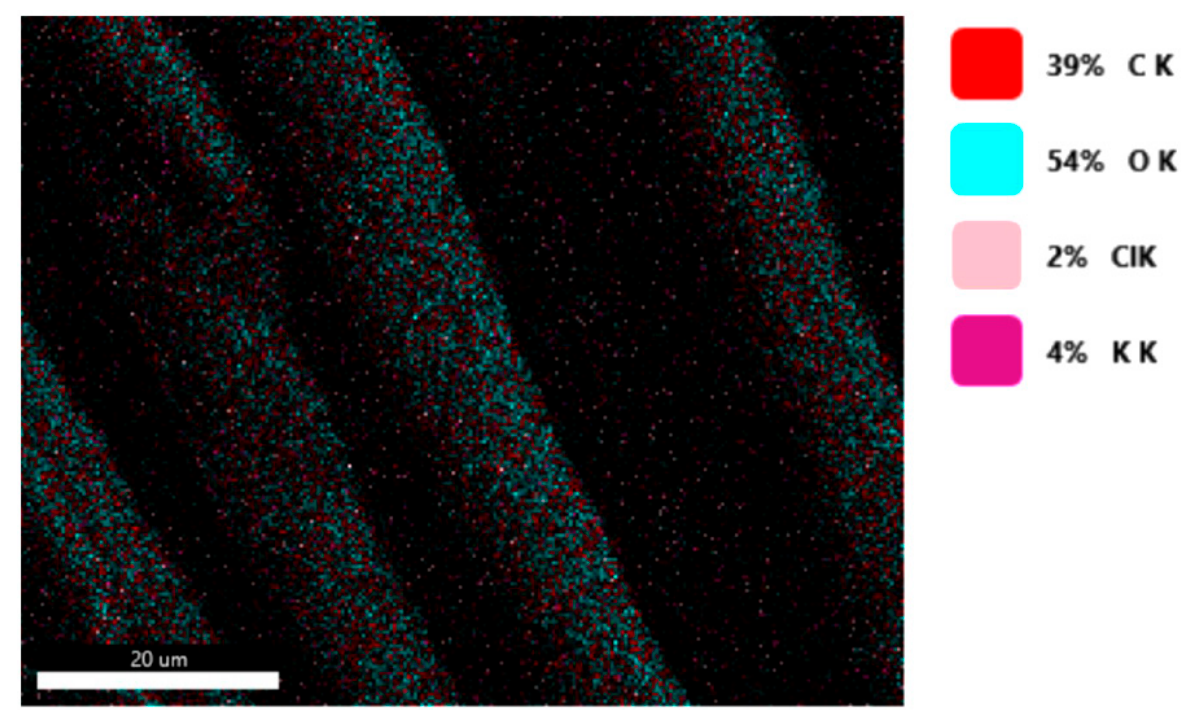
Materials 2021 , 14 , x FOR PEER REVIEW Figure 17. Smart elemental mapping overlay for sample S3 treated in RF plasma O 2 , using RF 2 generator and power 100 W.